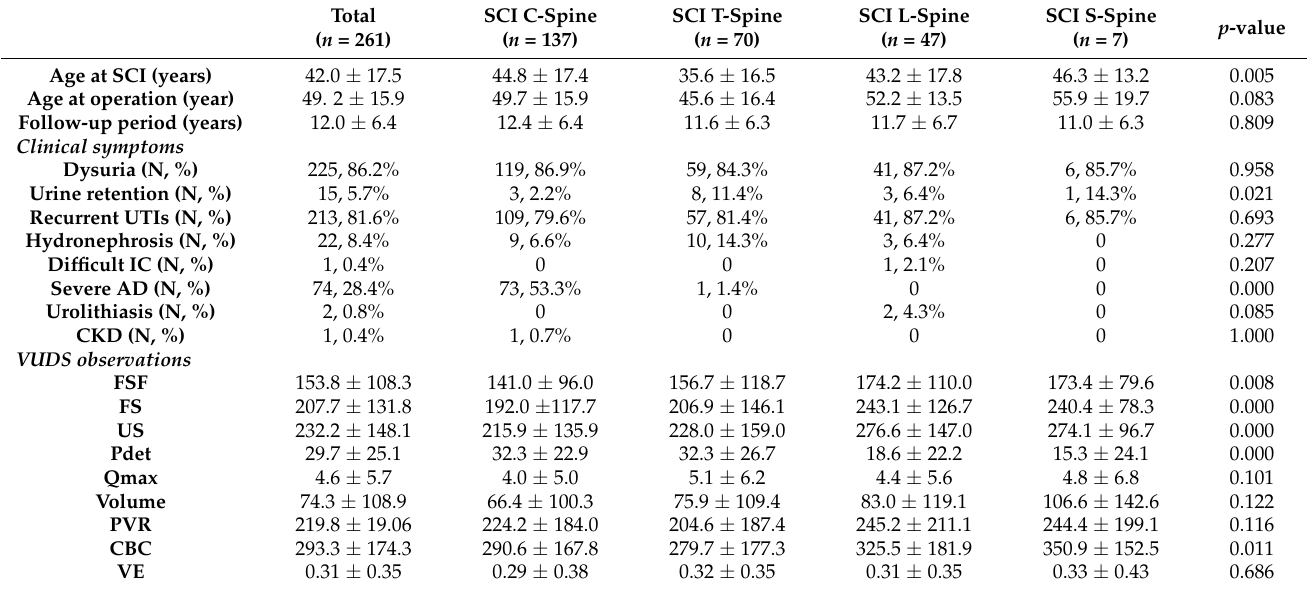
Table 1. Pre-operative clinical data according to different spinal cord injury